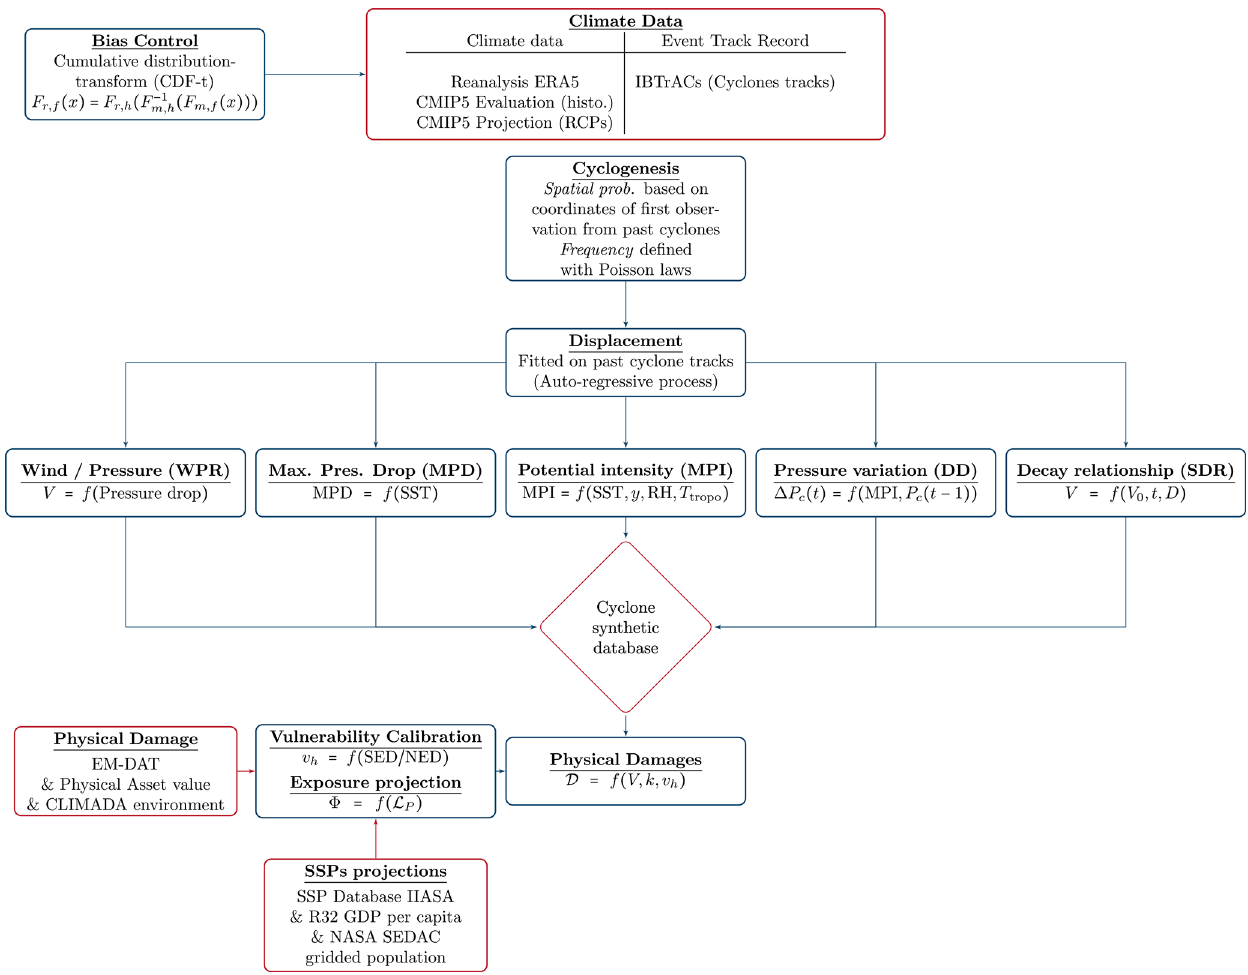
Figure 1. Cyclone generation Algorithm including a THERmodynamic module for Integrated National damage Assessment (CATHERINA)